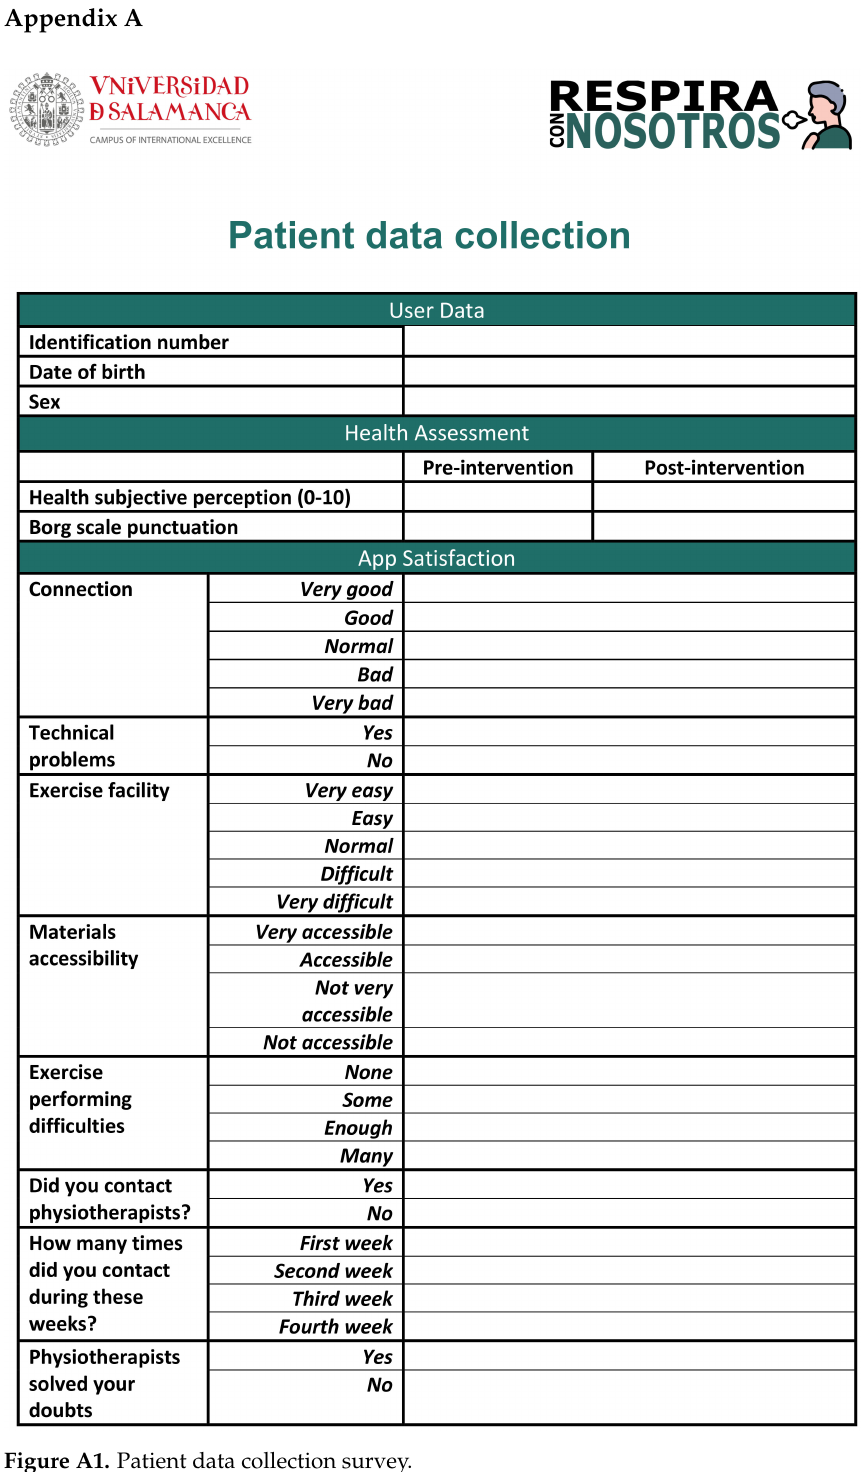
Figure A1. Patient data collection